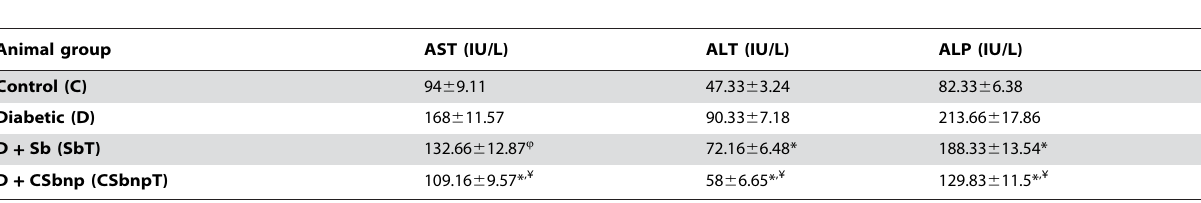
Table 2. Effect of Sb and CSbnp over liver metabolic enzymes in diabetic rats.